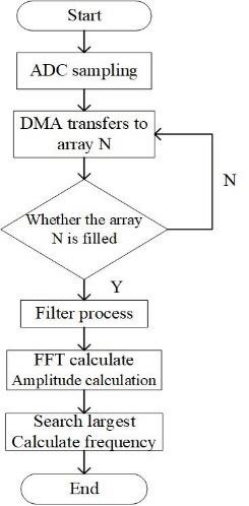
Fig. 6. Software design flowchart.